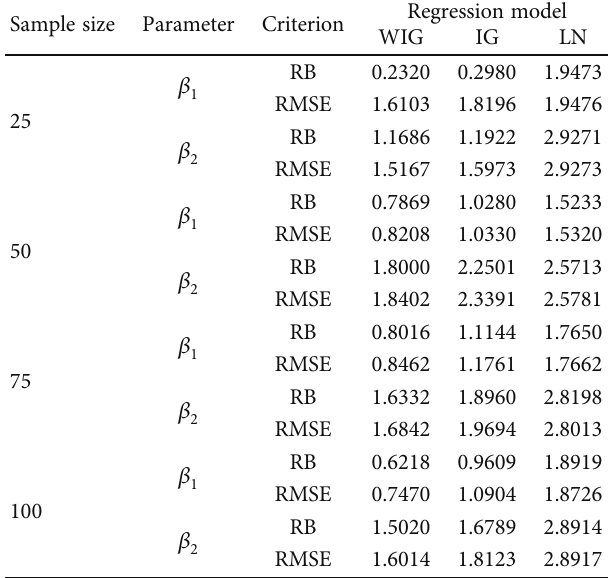
Table 1: The values of RMSE and RB of the Bayes estimators of the regression coe ffi cients for WIG model along with corresponding values for IG and LN